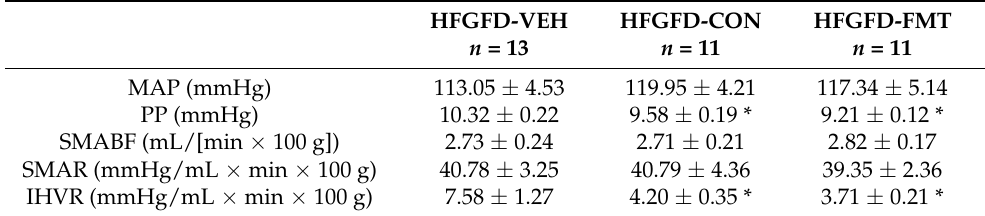
* p ≤ 0.05 versus HFGFD-VEH. Abbreviations: HFGFD, high-fat, high-glucose/fructose diet; IHVR, intrahepatic vascular resistance; MAP, mean arterial pressure; PP, portal pressure; SMABF, superior mesenteric artery